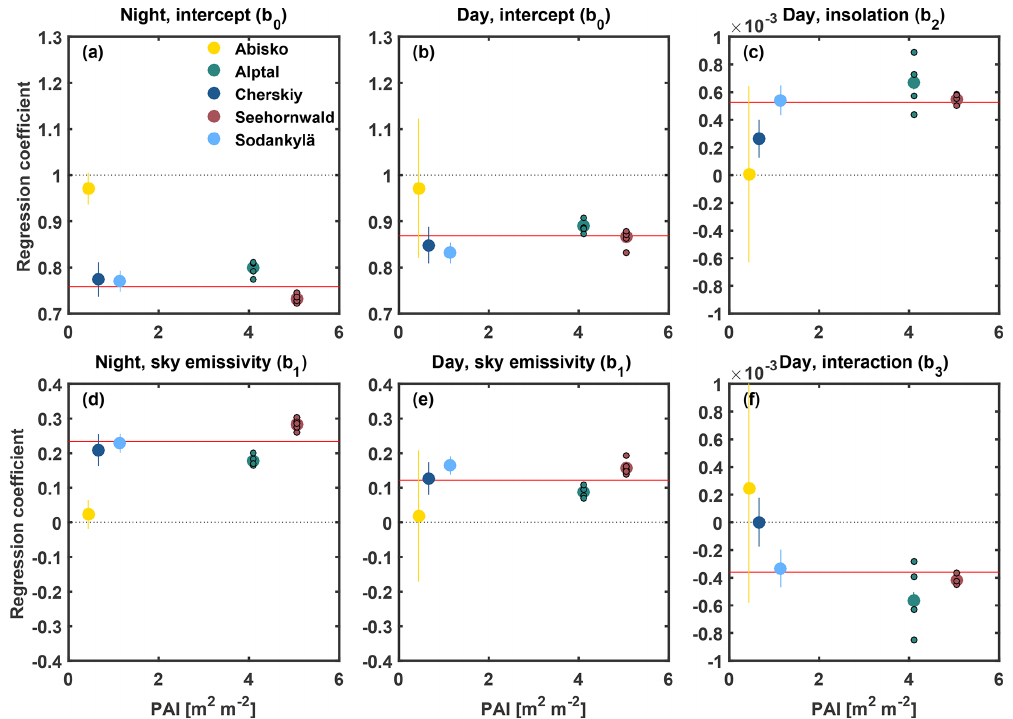
Figure 3. Regression coefficients (Eq. 6) for forest stands at Abisko (yellow), Alptal (green), Cherskiy (dark blue), Seehornwald (maroon), and Sodankylä (light blue), with small circles indicating individual seasons for Alptal and Seehornwald and solid lines indicating 95% confidence intervals. Red lines display regression coefficients calculated from a combination of Alptal (season 2005), Cherskiy, Seehornwald (season 2009), and Sodankylä. Intercept b 0 and regression coefficient for ε sky b 1 are differentiated for night ( a and d , respectively) and day ( b and e , respectively). Regression coefficient for insolation b 2 and regression coefficient for interaction of ε sky and insolation b 3 are shown for day only ( c and f , respectively). Regression coefficients involving insolation have the unit of square metres per watt (W − 1 m 2